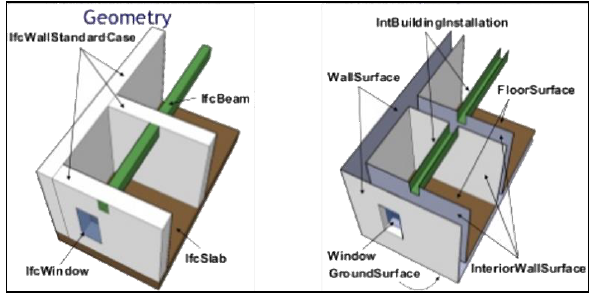
Figure 2. BIM data and CityGML data (Thomas H Kolbe , 2010)